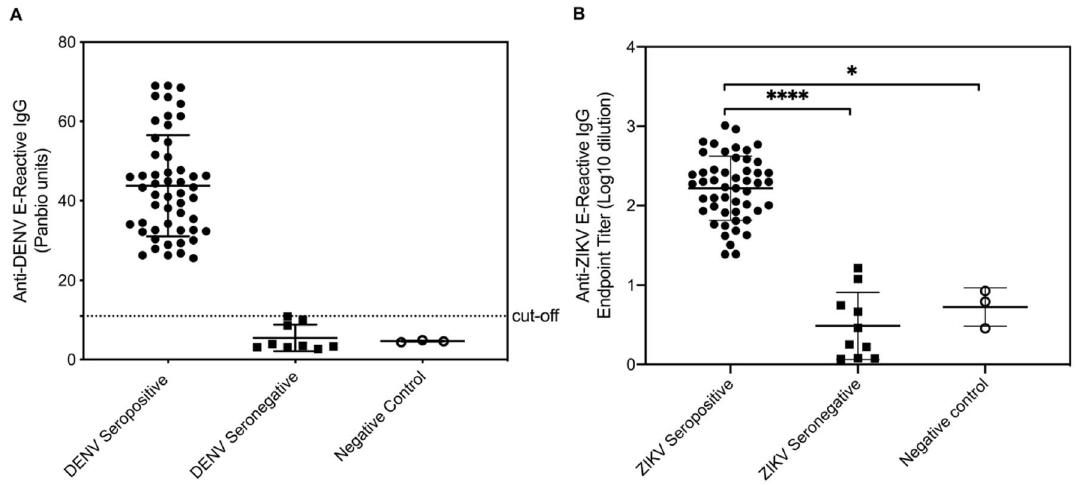
Figure 1. DENV and ZIKV seroprevalence in healthy adult residents of a DENV-endemic region in Thailand. (A) DENV E antigen-specific IgG was quantified by ELISA. Data are presented as the mean ± SD of 52 DENV seropositive and 9 DENV seronegative samples from Thai subjects and 3 samples from negative control subjects. (B) Endpoint titers of ZIKV E antigen-specific IgG were determined by ELISA. Data are presented as the mean ± SD of 51 ZIKV seropositive and 10 ZIKV seronegative samples from Thai subjects and 3 samples from negative control subjects. Each symbol represents an individual sample. *P < 0.05 and **** P < 0.0001 by the Kruskal–Wallis test.